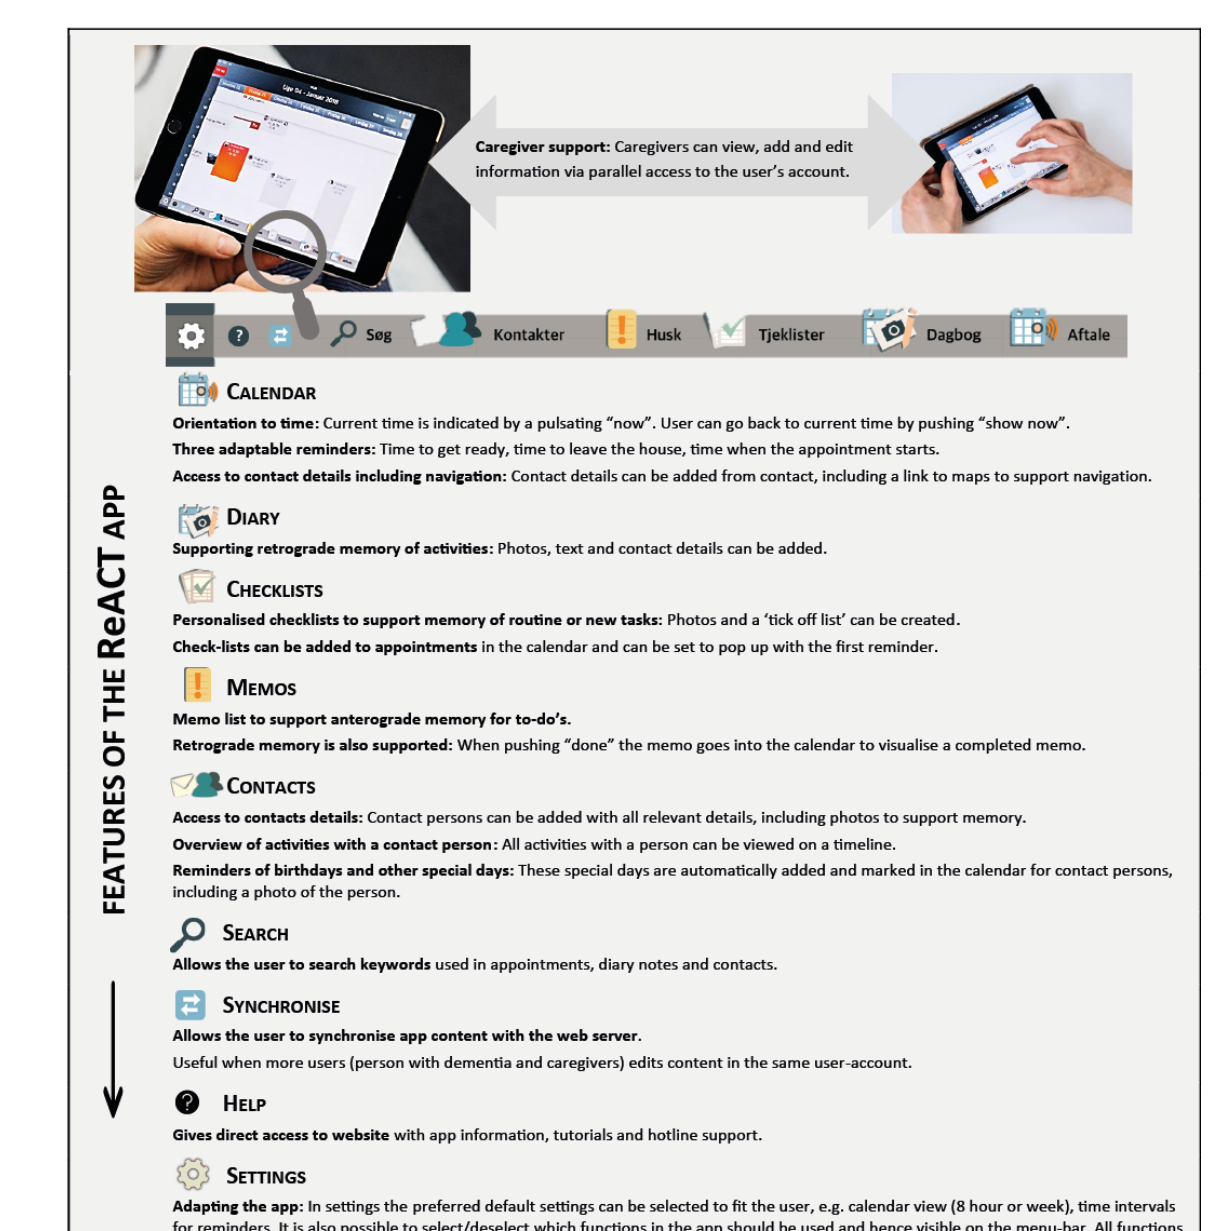
Figure 1. Features of the ReACT